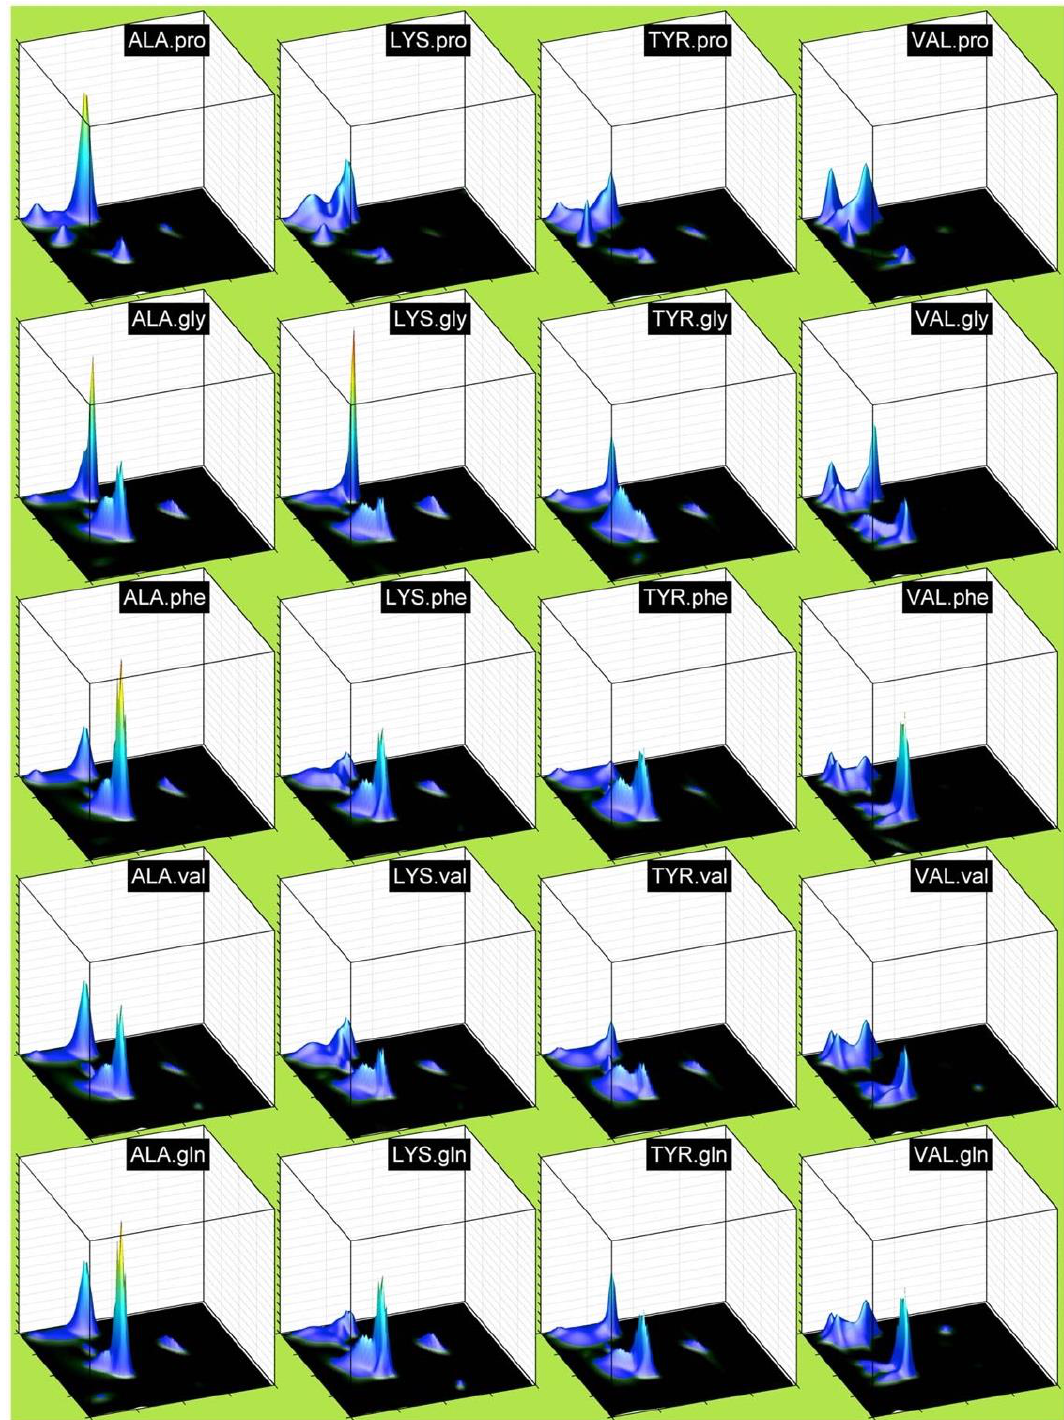
Figure 7. Ramachandran plots of alanine, lysine, tyrosine and valine in the presence of the indicated downstream neighbors. Distributions with different upstream neighbors were integrated. Taken from [19] (open access).